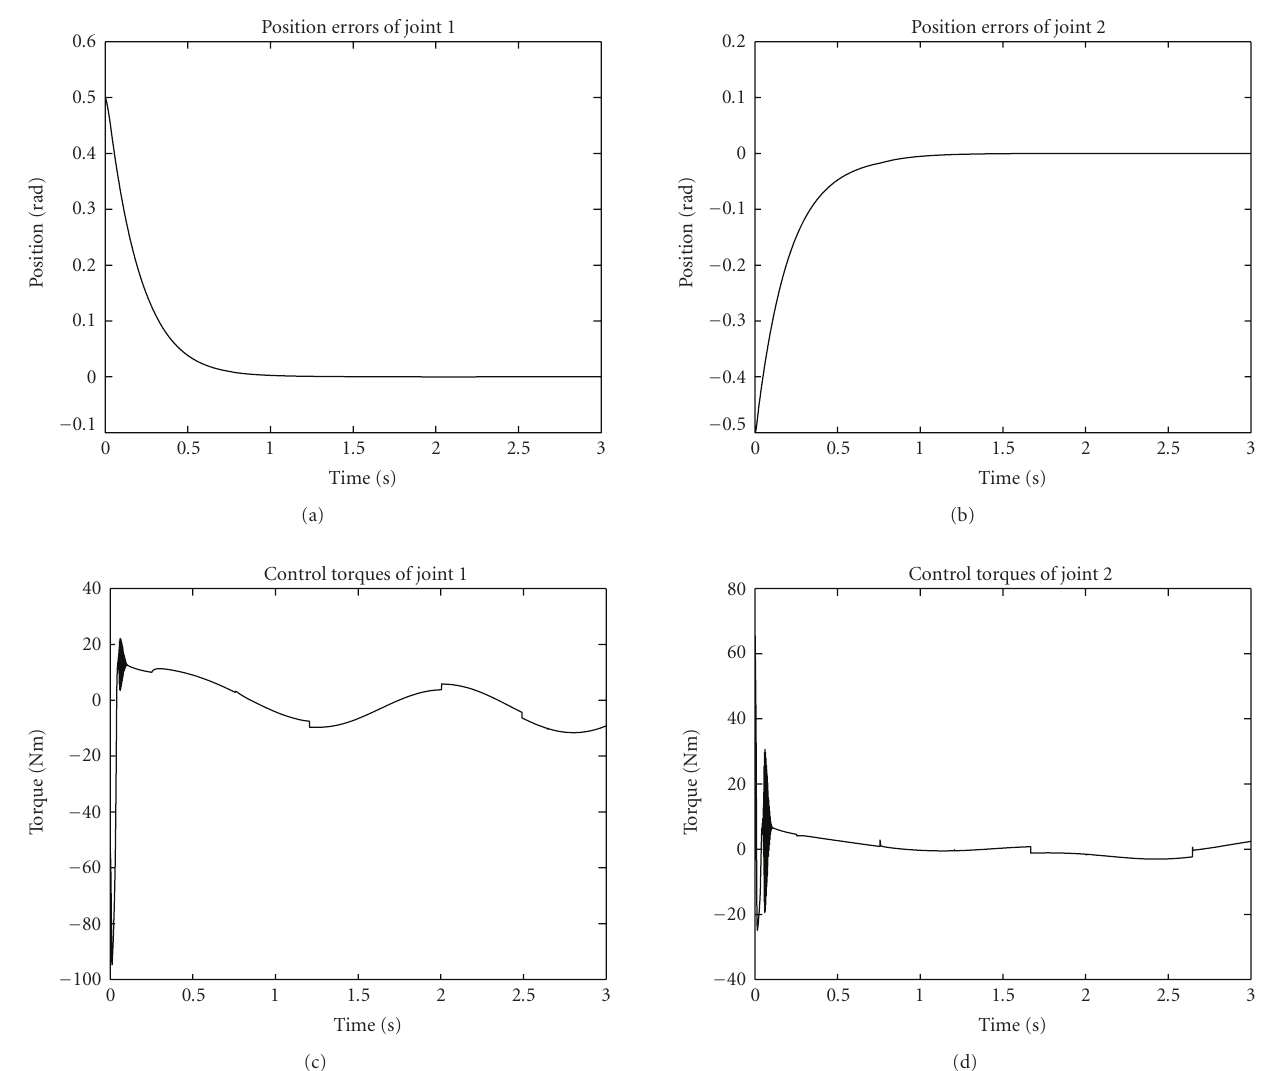
Figure 2: Response using proposed conventional robust control law ( α =